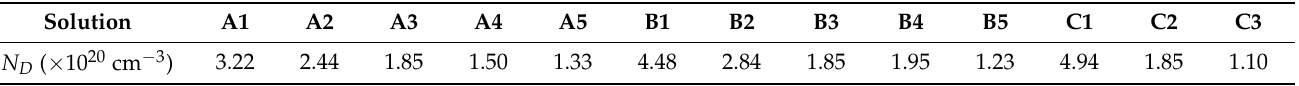
Table 3. The donor densities of passive film formed on 201 low-nickel stainless steel in different solutions.